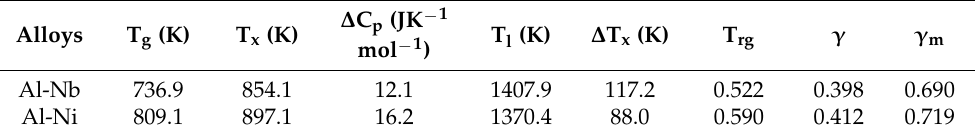
Table 1. The thermal properties and ΔT x , T rg , γ of alloys measured at 20 K/min heating rates.